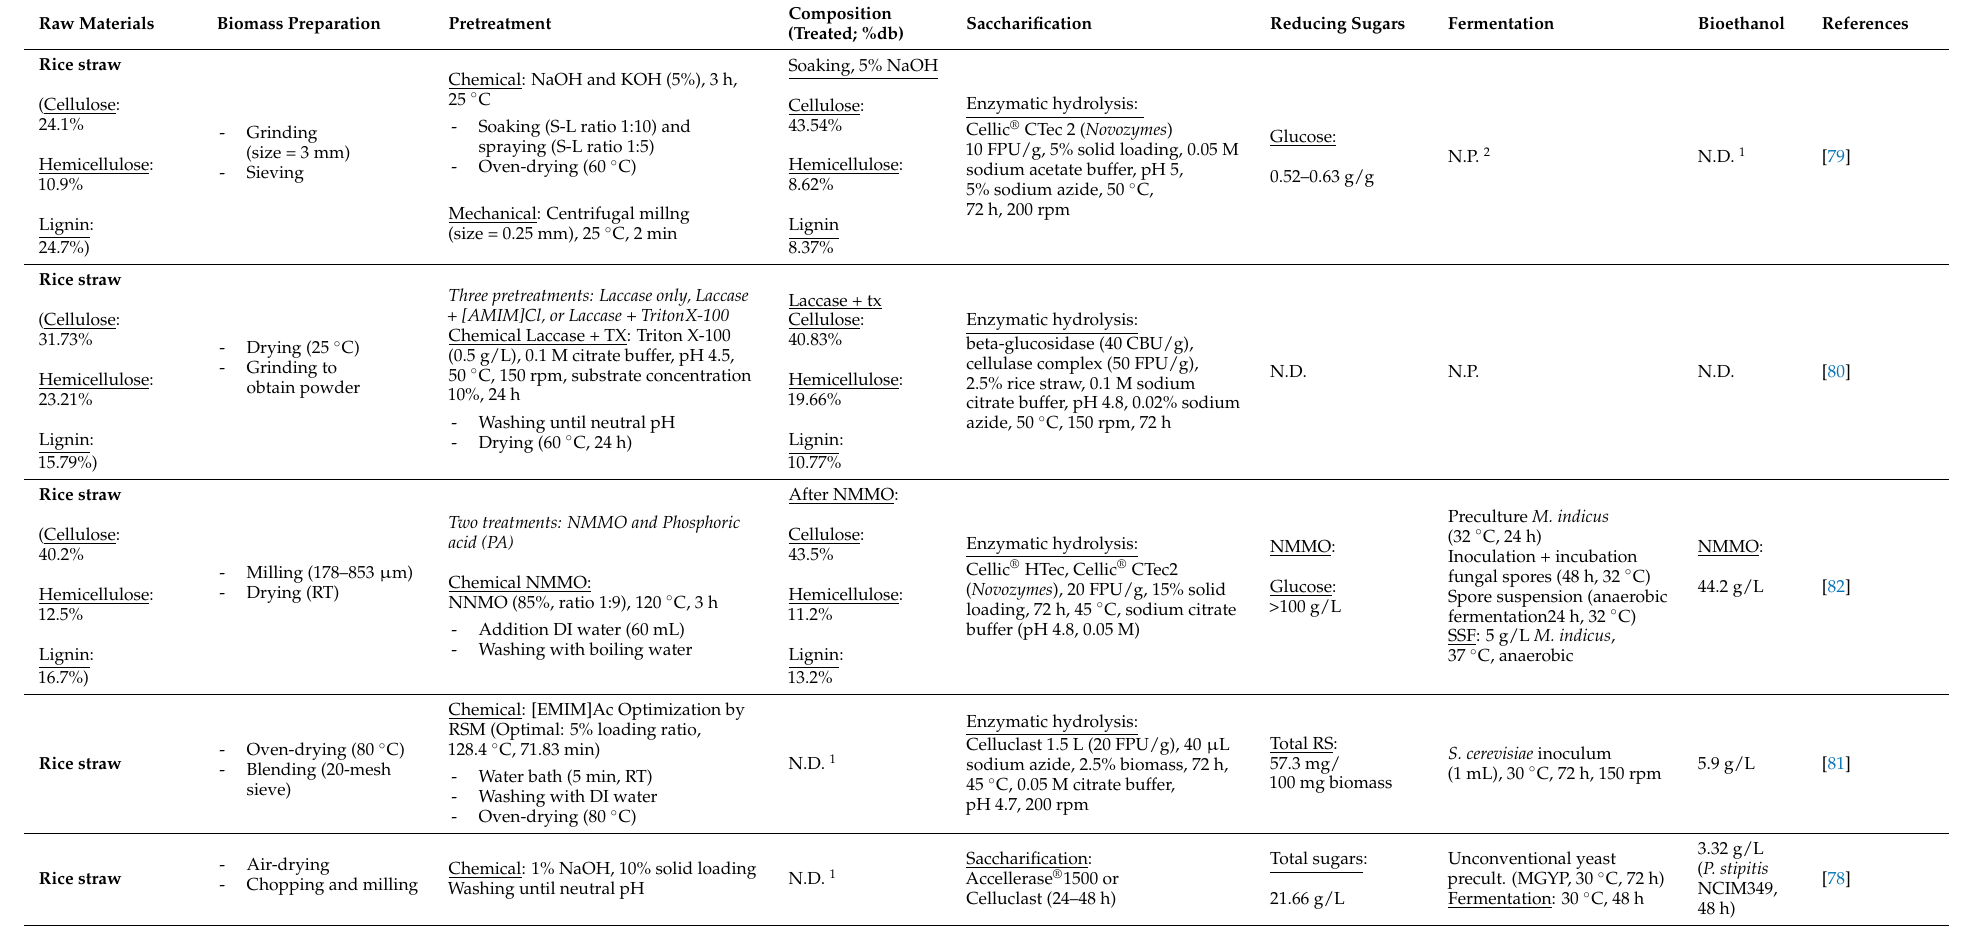
Table 4. Summary of recent experiments done for pretreatment of rice